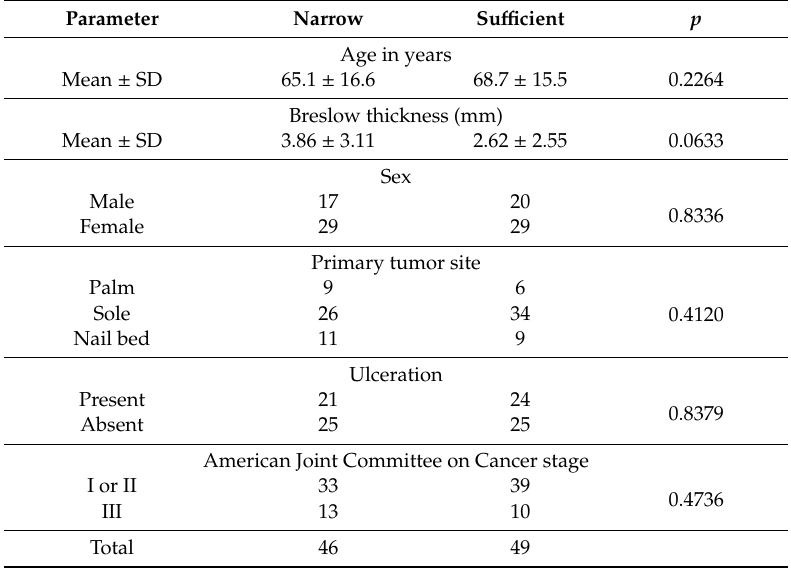
Table 5. Comparison between narrow and su ffi cient margins from nodules for stage I–III